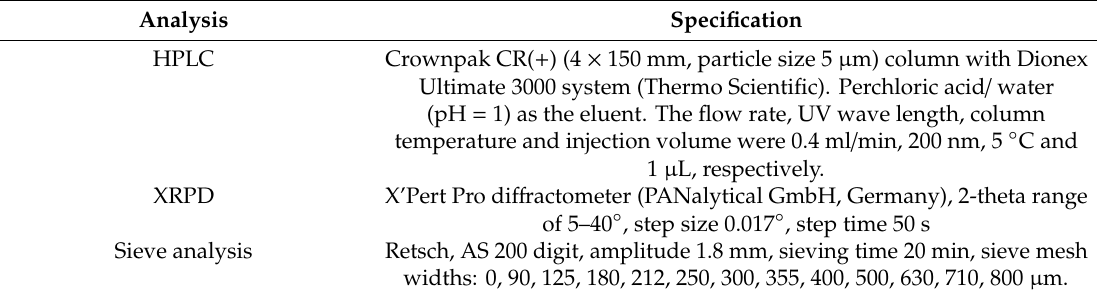
Table 2. Specifications of the applied